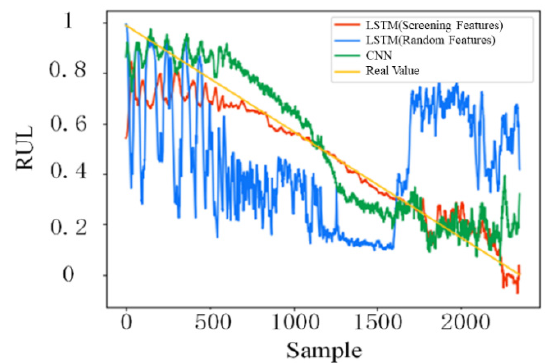
Figure 12. RUL prediction results for different cases.